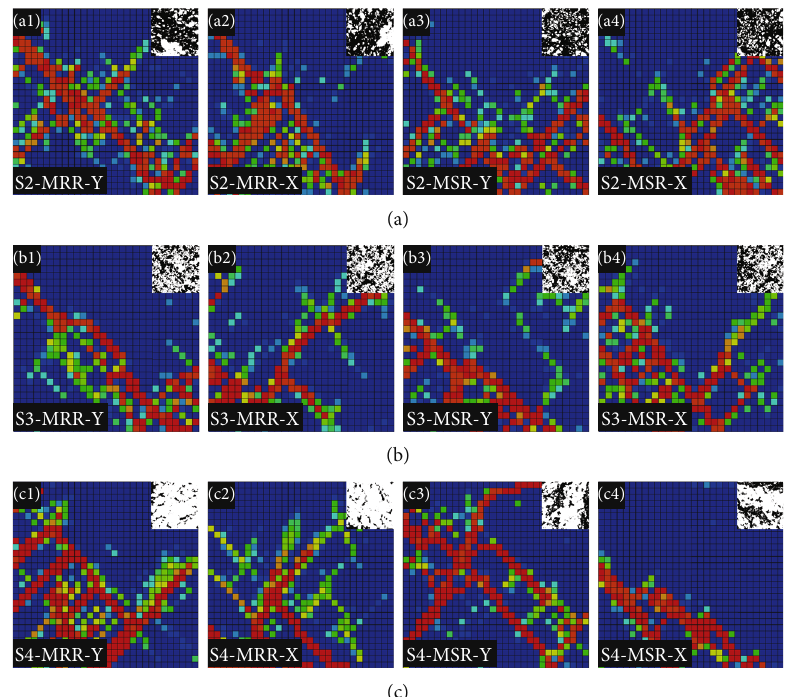
Figure 10: Compressive damage of the most representative regions (MRRs) and the most special regions (MSRs) at the beginning of the residual stage under two loading